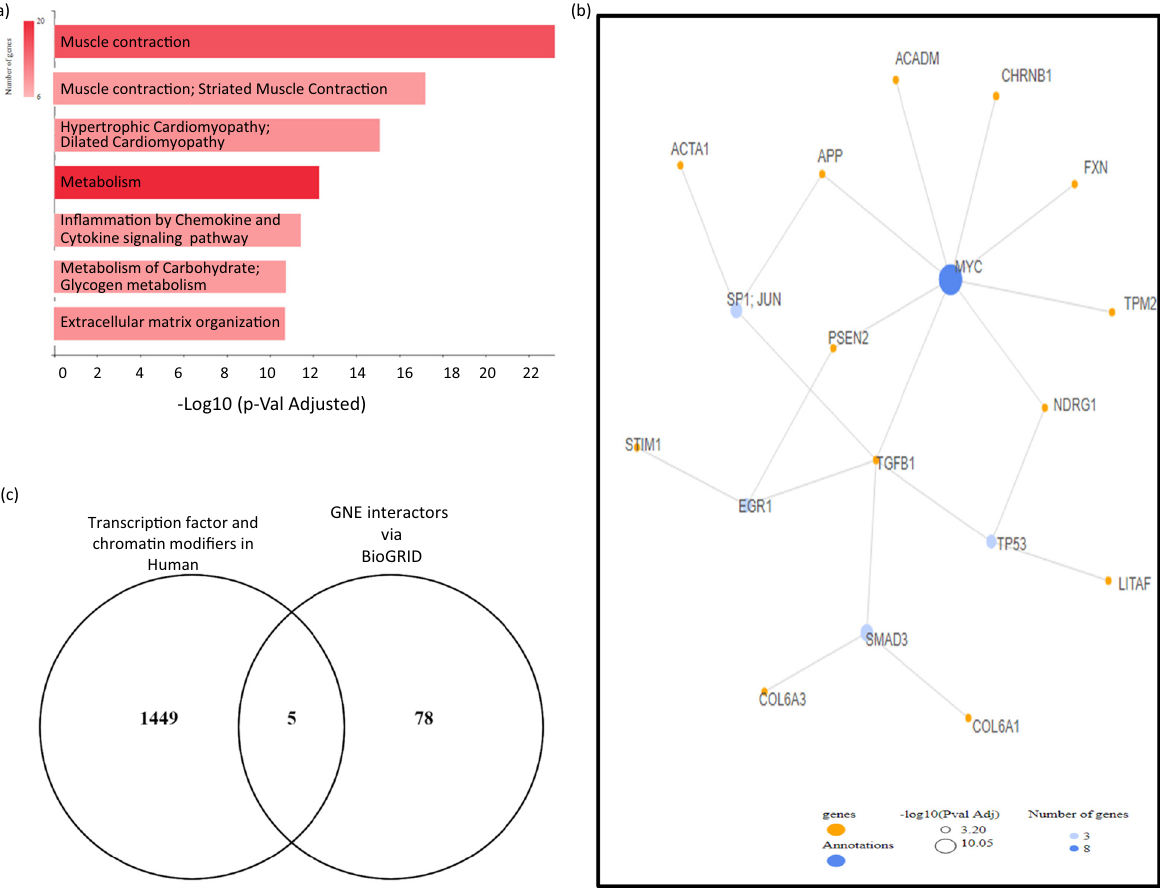
Figure 4: ( a ) The reported di ff erential genes in patients with V727M mutant were analyzed using GeneCodis to identify key pathways involved. ( b ) Key transcription pathways and the tartget genes regulated as per GeneCodis tool. ( c ) Common TFs identi fi ed via human transcription factor or chromatin modi fi ers and BioGRID - based GNE protein interaction